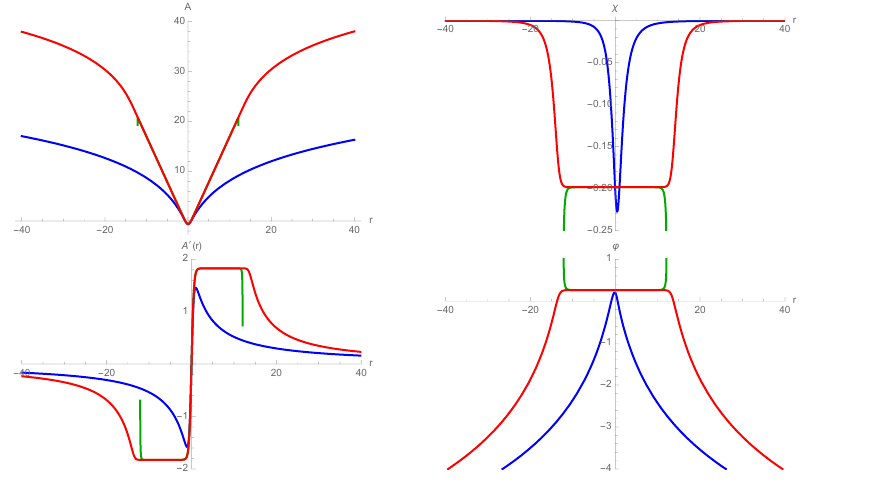
Figure 4 . Three solutions with f ’ (0) = 0 : 2, (cid:31) (0) = (cid:0) 0 : 2 g (Blue), f ’ (0) = ’ (cid:3) + 1 : 9 (cid:2) 10 (cid:0) 16 , (cid:31) (0) = (cid:31) (cid:3) g (Red), and f ’ (0) = ’ (cid:3) + 2 : 0 (cid:2) 10 (cid:0) 16 , (cid:31) (0) = (cid:31) (cid:3) g